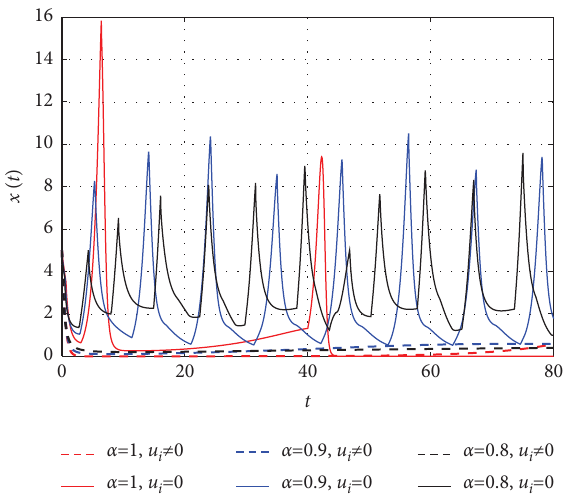
� 0 . 0002 , C � 0 . 0005 , C � 0 . 0003 , 1 2 3